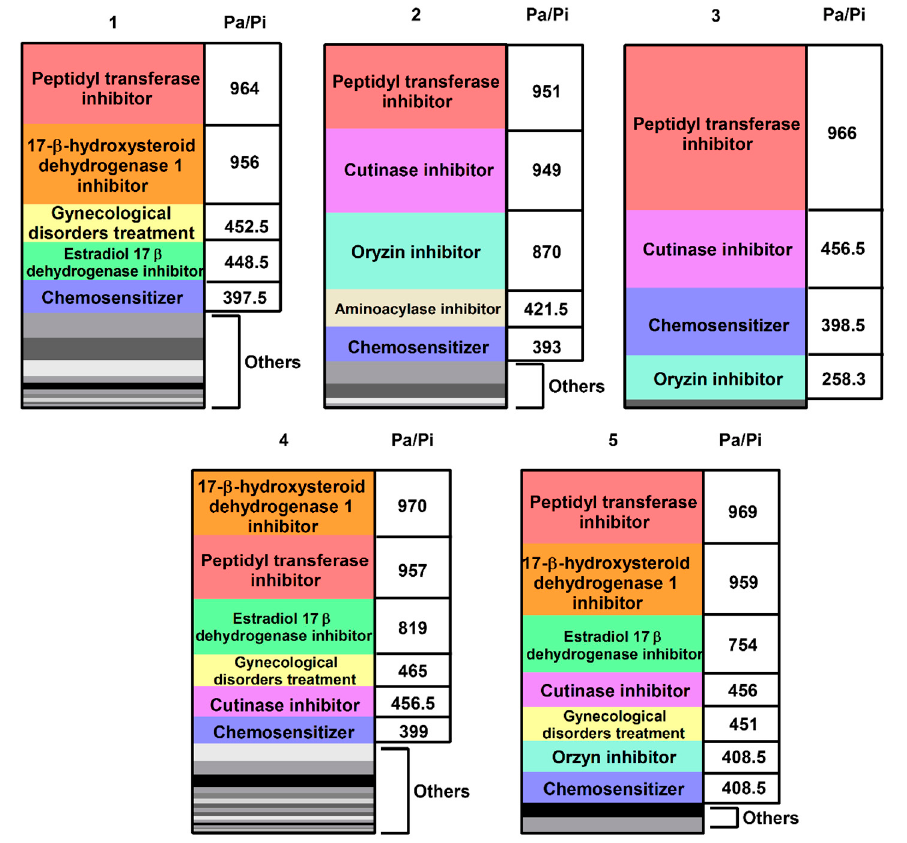
Figure 2. Most probable biological activities predicted by PASS online for the five compounds. Activities were ranked according to the ratio (Pa/Pi). Numbers on the panels indicate the corresponding BCC in Figure 1.